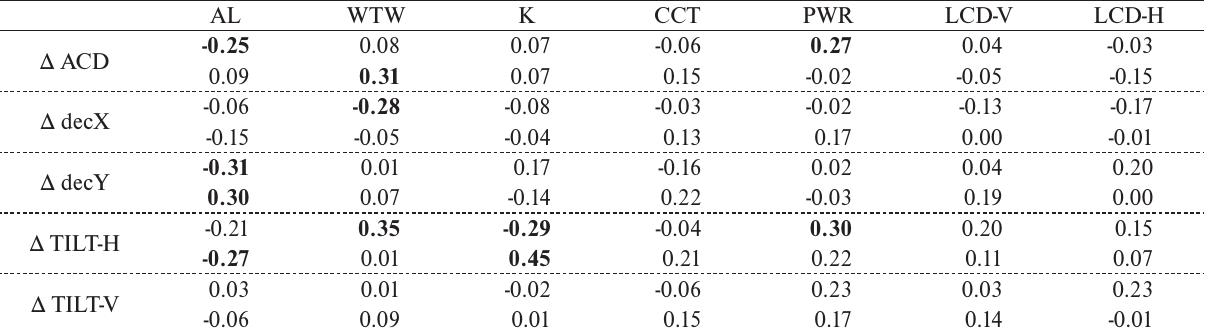
Table 2. Results of Pearson's correlation coefficients between eye or IOL parameters and differences in IOL position change (correlation of absolute values are in the second line of each